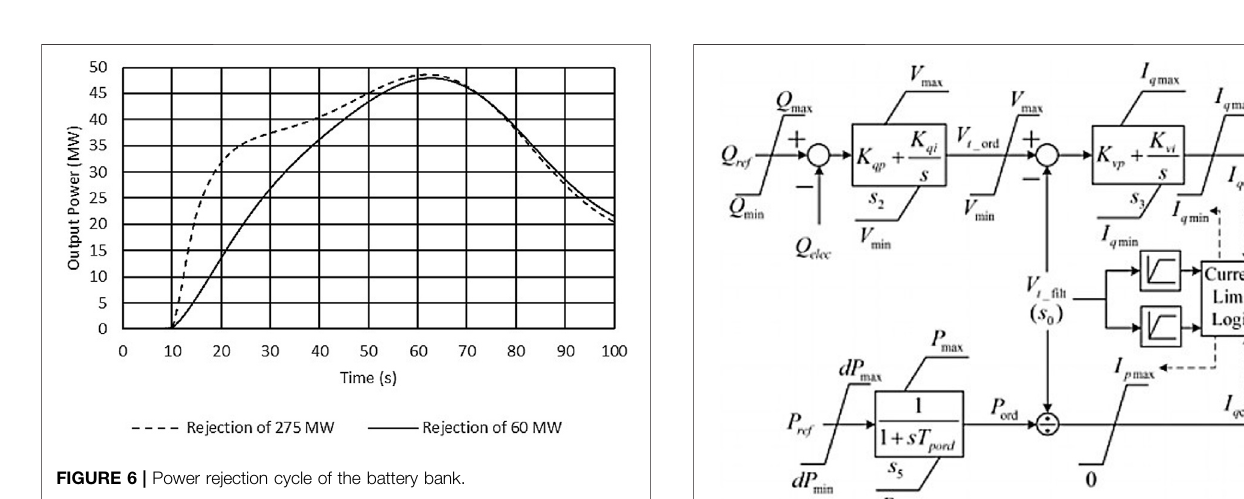
FIGURE 5 | Frequency of the system when rejection of 60 MW generation from the system occurs.